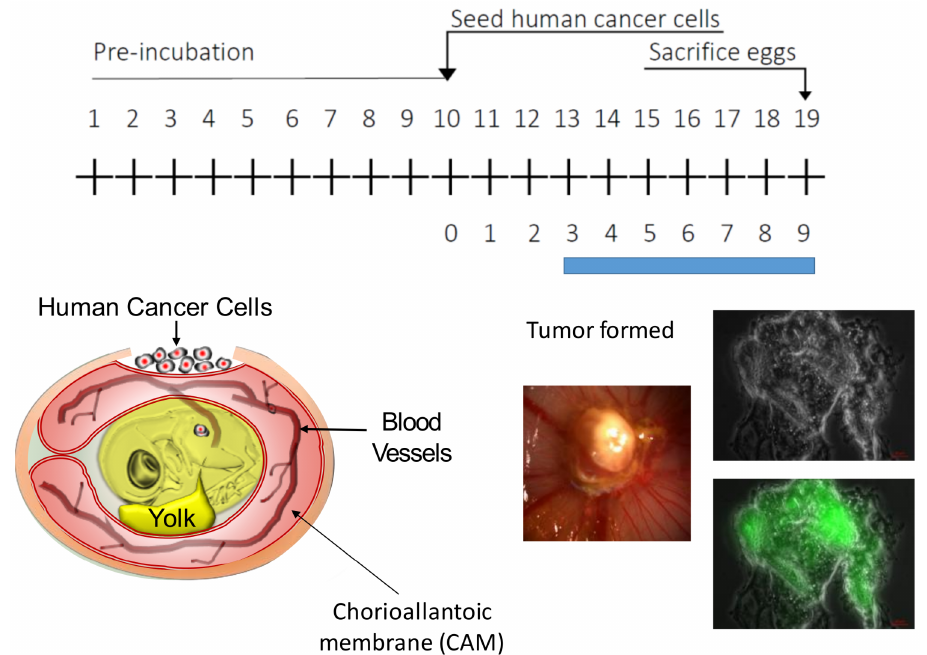
Figure 1. The CAM assay. Fertilized eggs are incubated at 37 ◦ C and under 65% humidity with occasional movement. By Day 5, embryo is surrounded by a nutrient rich membrane called chorioallantoic membrane (CAM). A window is made on the egg shell and human ovarian cancer cells OVCAR8 are placed on the CAM membrane. Three days after the transplantation, a tumor is formed. When GFP expressing cancer cells are used, we can observe green fluorescent tumor. Modified from Figure 1 of Vu et al.